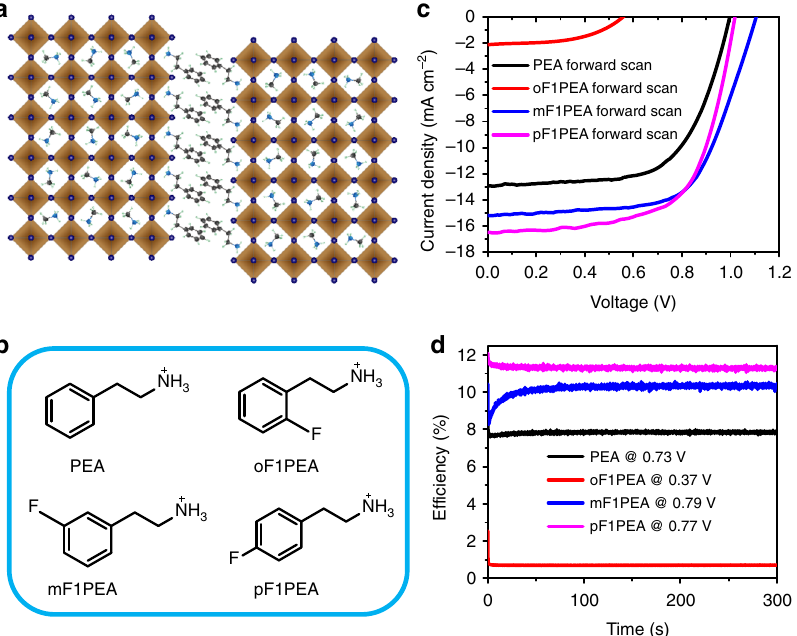
Fig. 1 2D OIHPs with PEA fl uorinated at different positions and their device characterization: a crystal sketch of PEA based 2D OIHP ( n = 4); b molecular structures of PEA and its fl uorinated derivatives in this study; c current-density-voltage ( J - V ) curves (forward scan) under 1 sun condition (AM.1.5 G) with a solar simulator; d device performance tracking under constant illumination and at maximum power